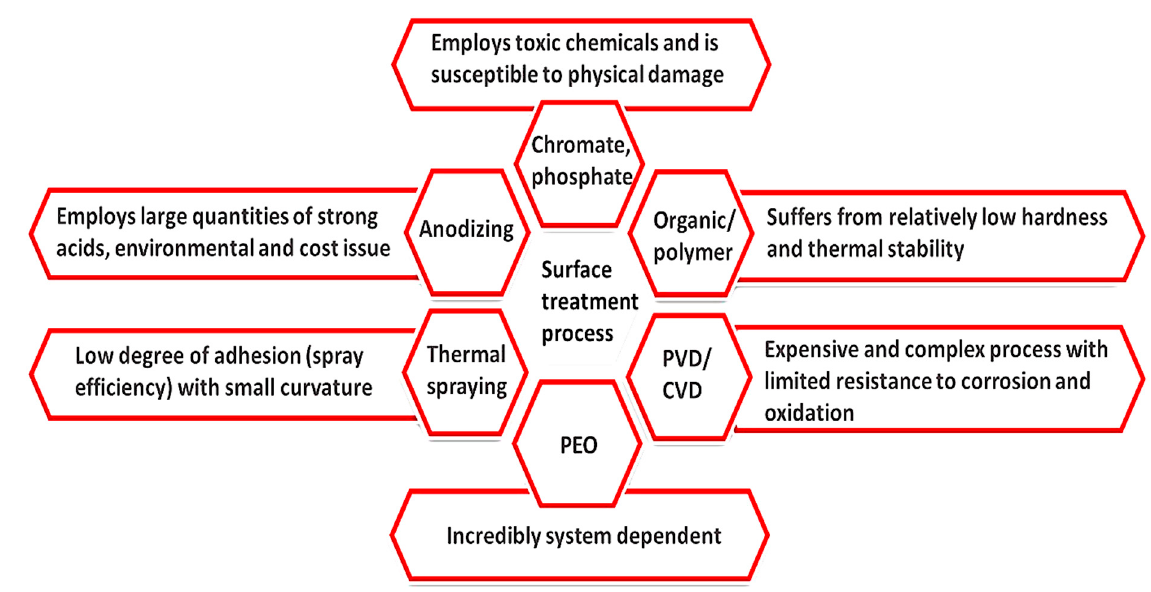
Figure 2. Comparison of common surface treatment techniques, a limitation for valve metals and alloys. Adapted from [12].